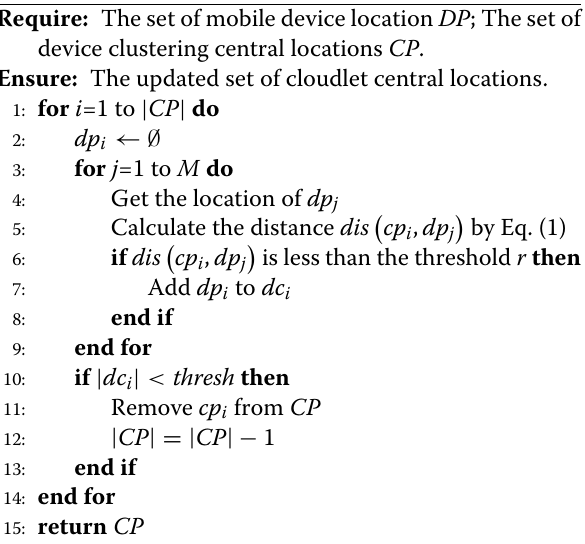
Algorithm 2 Energy-aware location filtering ( DP , CP